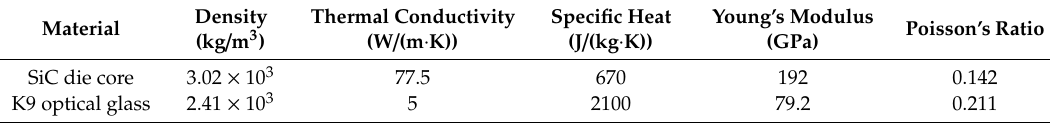
Table 1. Material properties of die core and K9 optical glass